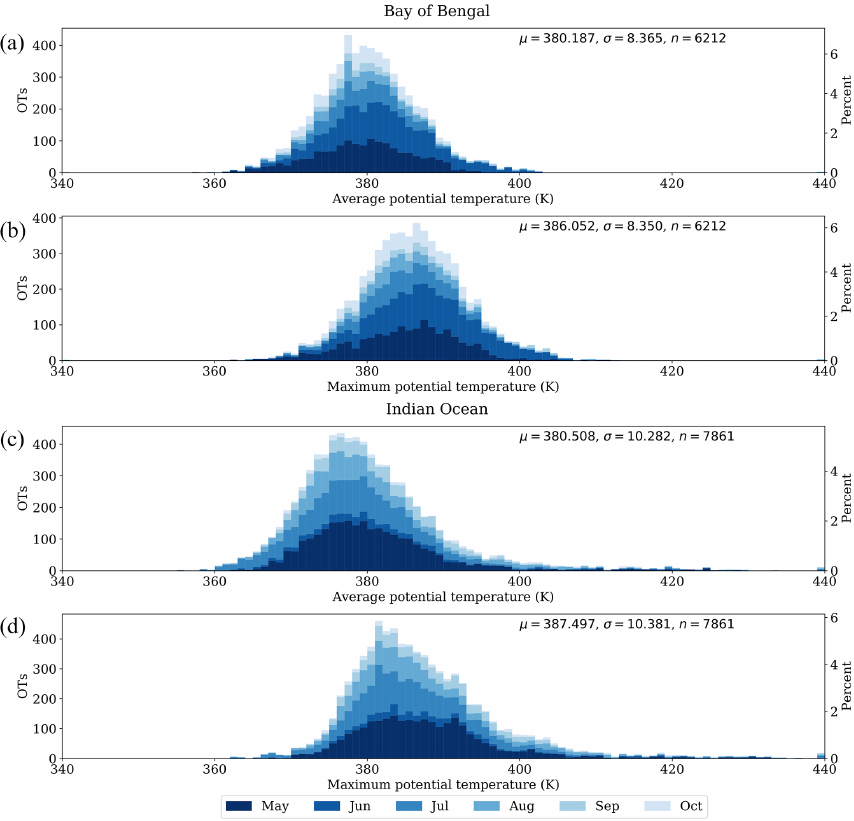
Figure 7. As Fig. 5, but for the potential temperature distributions of OTs over the Bay of Bengal region (a, b) and the Indian Ocean region (c, d)